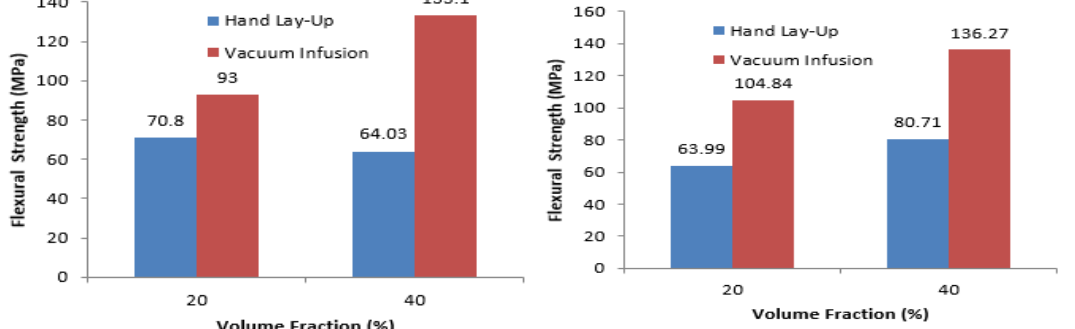
Figure 3: Shows the relationship of volume fraction Figure 4: Shows the relationship of volume fraction on